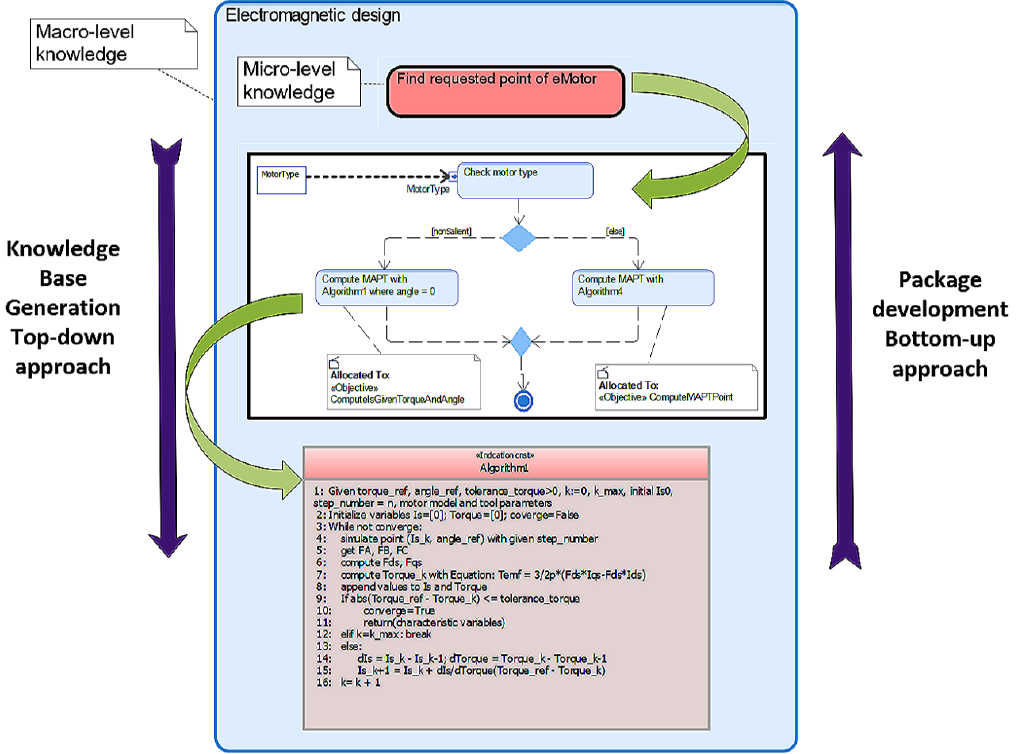
Figure 5. eMachine product model example for the rotor lamination.